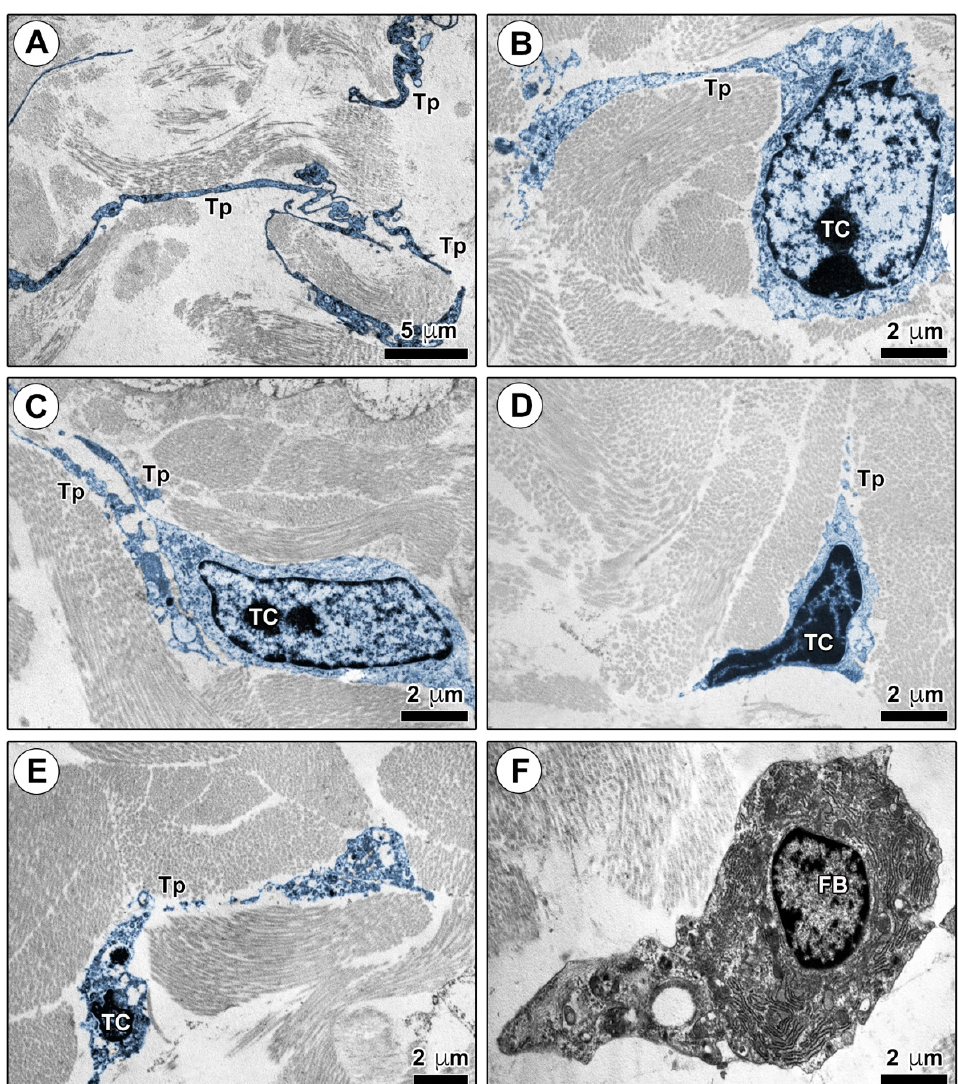
Figure 5. Ultrastructural alterations of telocytes (TCs) in the skin of bleomycin-treated mice. ( A – F ) Representative trans- mission electron microscopy photomicrographs of skin ultrathin sections from mice treated with subcutaneous injections of bleomycin for 2 weeks ( A – C ) or 4 weeks ( D – F ) stained with UranyLess and bismuth subnitrate solutions. TCs and telopodes have been digitally colored in blue. The network of telopodes appears reduced in the dermis of mice treated with bleomycin for 2 weeks ( A ); TCs embedded in a matrix composed of thickened and closely packed collagen bundles often display swollen cell body and telopodes with prominent cytoplasmic vacuolization ( B , C ). Shrinkage, shortening and breaking of telopodes along with apoptotic chromatin condensation and nuclear fragmentation are evident in the few TCs detectable in the dermis of mice treated with bleomycin for 4 weeks ( D , E ); fibroblasts are not in contact with telopodes ( F ). Scale bar: 5 μ m ( A ), 2 μ m ( B – F ). FB, fibroblast; TC, telocyte; Tp,